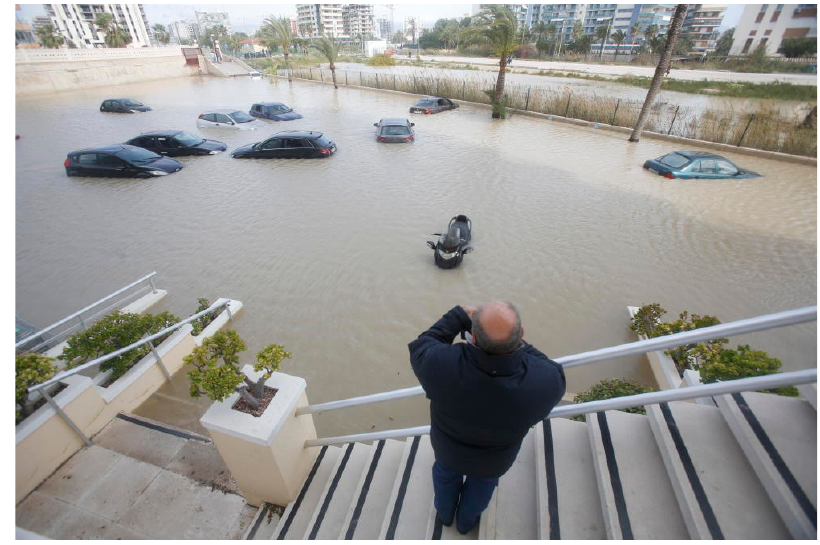
Figure 10. Flooded parking of one blocks of apartments in San Juan Beach. Note: episode of the 21 August of 2019. Source: [63].